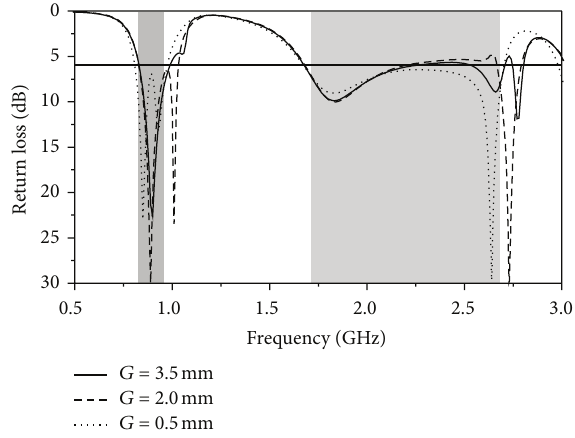
Figure 6: Return loss characteristics for various gap